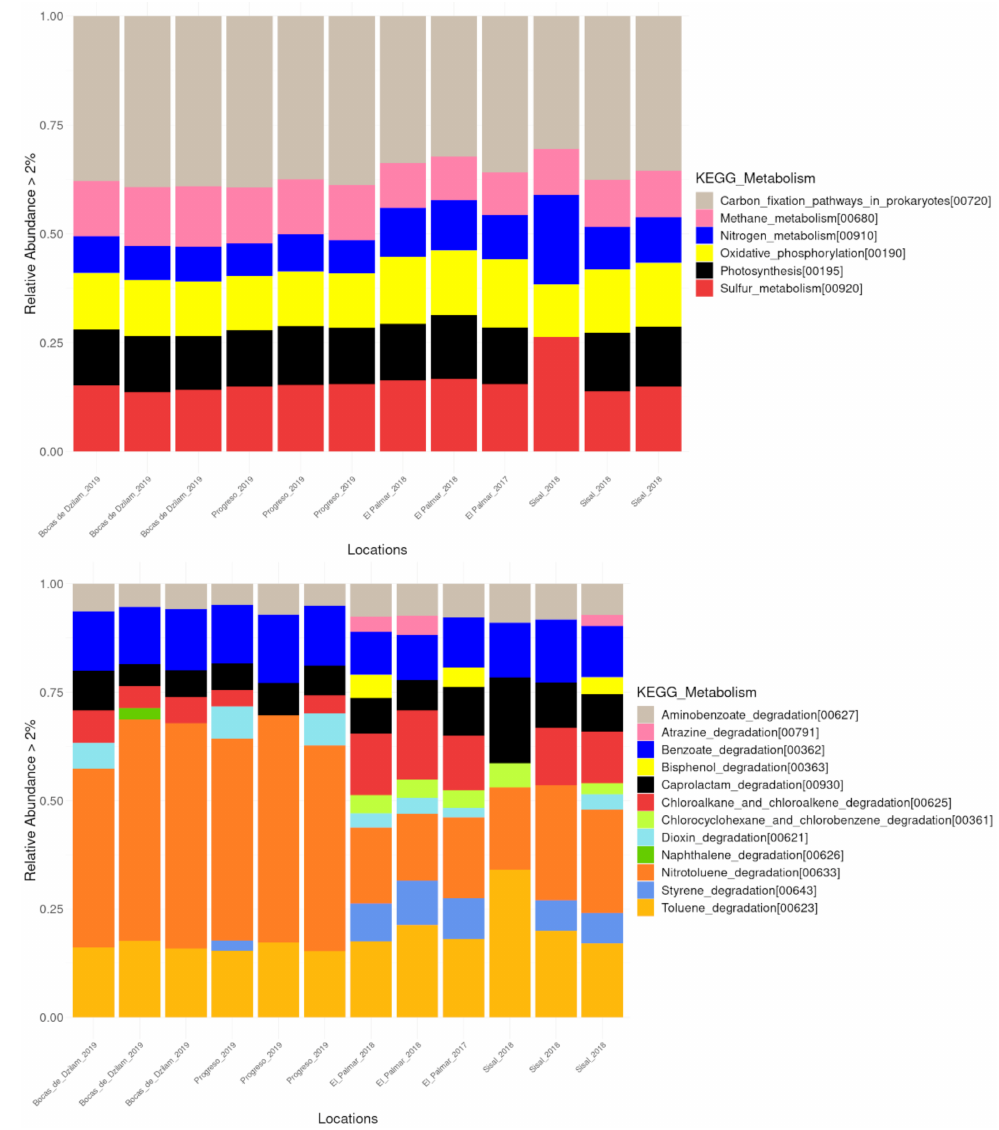
Figure 7. Metabolic pathways associated to biogeochemical (upper) and xenobiotics (bottom)